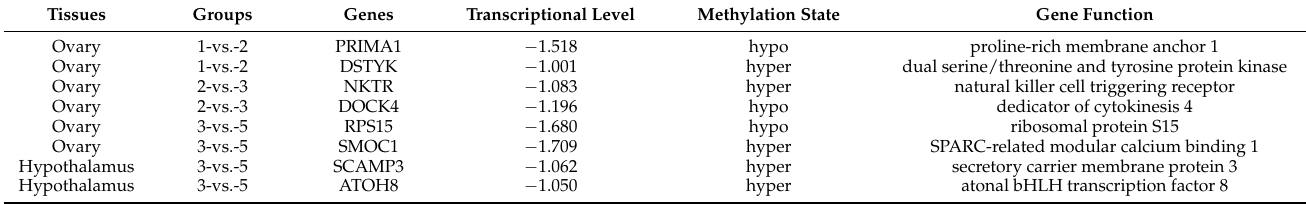
hyper natural killer cell triggering receptor